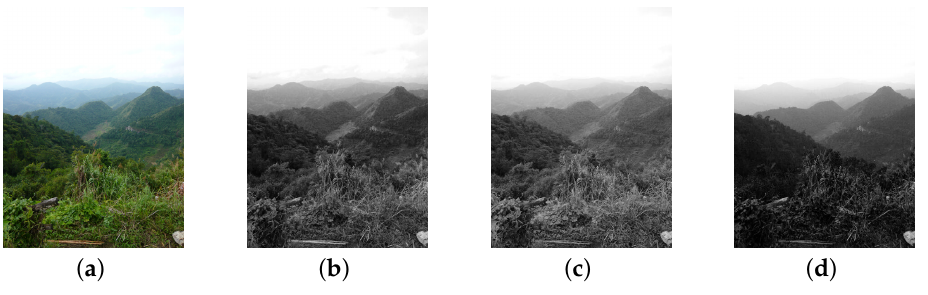
Figure 6. The first image in the INRIA Holidays database and the related R, G, B components. ( a ) Original image; ( b ) R component; ( c ) G component; ( d ) B component. The proposed scheme calculates the difference matrix of three components and encrypts them.